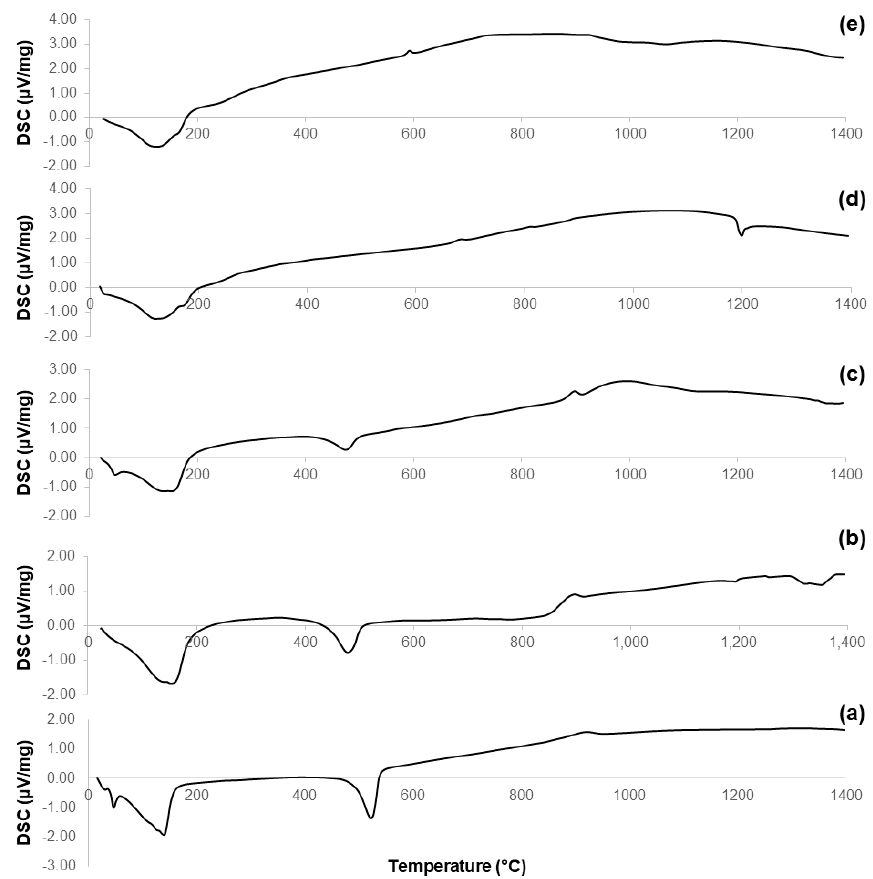
Figure 5. DSC plots of: ( a ) 60S40C-140 carried out in air; ( b ) 60S38C2Fe-140 carried out in air; ( c ) 60S38C2Fe-140 carried out in argon; ( d ) 60S30C10Fe-140 carried out in air; and ( e ) 60S30C10Fe-140 carried out in argon. Table 3. Characteristic temperatures of non-calcined materials determined (when possible) from DSC plots.